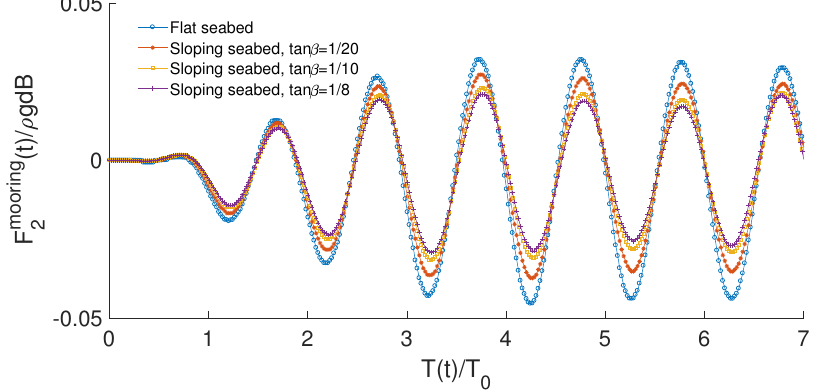
Figure 18. Comparison of time record of mooring line force F 2 ( t ) for wave frequency kd = 1.0 between flat seabed, sloping seabed with tan θ = 1/20, tan θ = 1/10 and tan θ = 1/8, respectively.